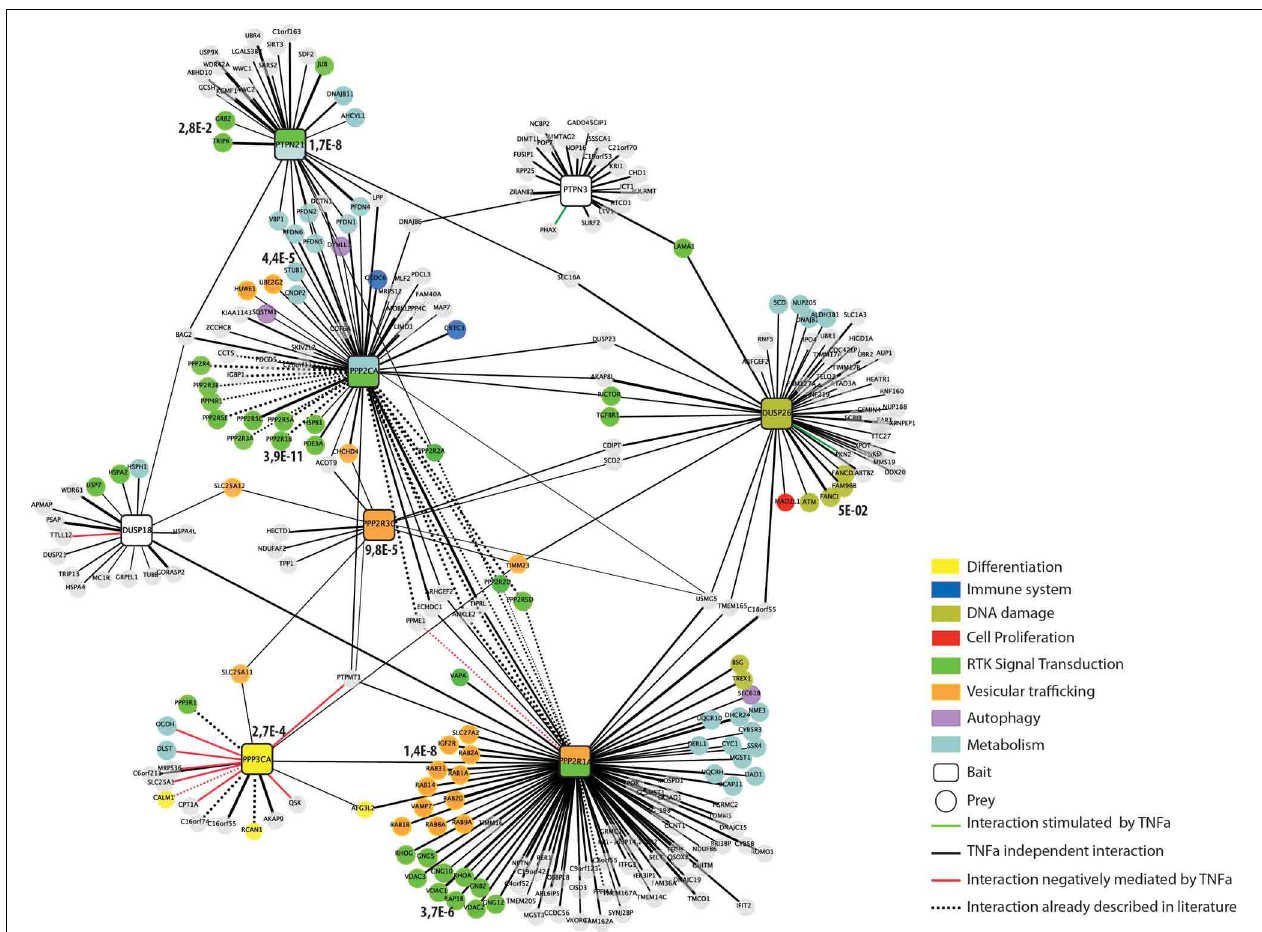
FIGURE 3 | The human phosphatase interactome. Phosphatases (squares) are linked to the experimentally identified interactors (circles) by edges. Edges are colored according to the functional relationships between the nodes they connect: interactions positively regulated by TNF α are in green; interactions negatively regulated by TNF α are red and TNF α independent interactions in black. Dashed lines represent interactions that